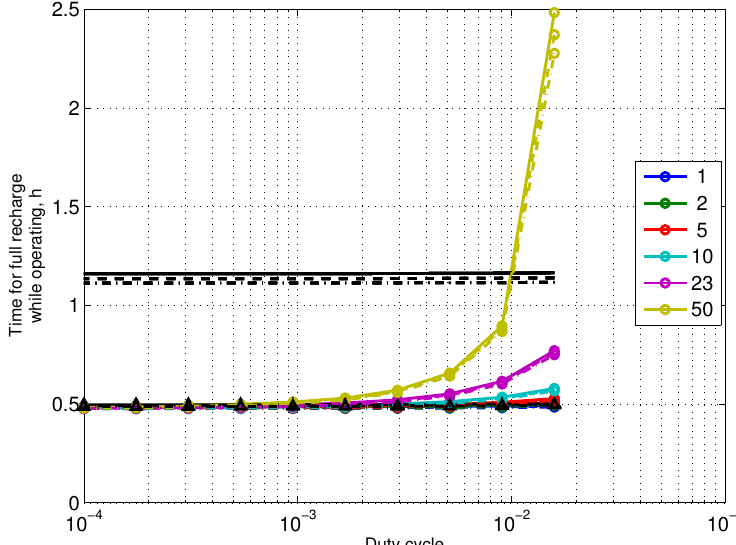
Figure 12. When M t = 1 and M r = 1, time for full recharge while operating with capacitor ( C s = 0.35 F). Non-WuR in black (without triangles), passive WuR in colors indicating number of nodes for different host duty cycles per node ( β (cid:48) w ). Semi-passive WuR in black with triangles. Line type indicates used SC